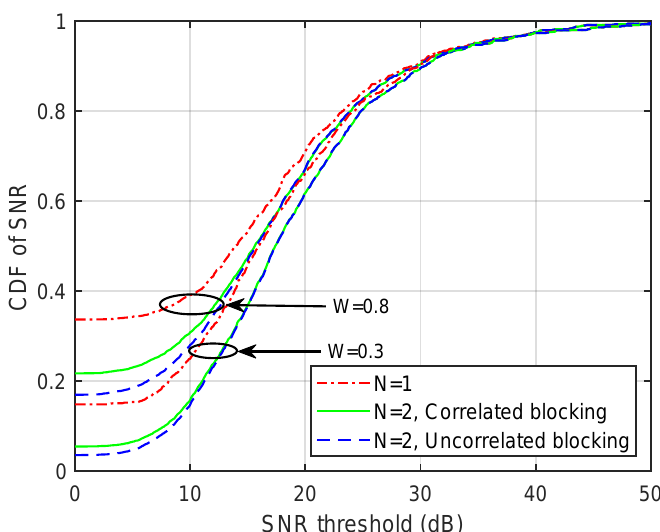
Figure 7. The distribution of SNR over 1000 network realizations when N = 1,2 using diversity combining, with and without considering blockage correlation at fixed values of blockage density λ bl = 0.6 and base station density λ bs = 0.3.